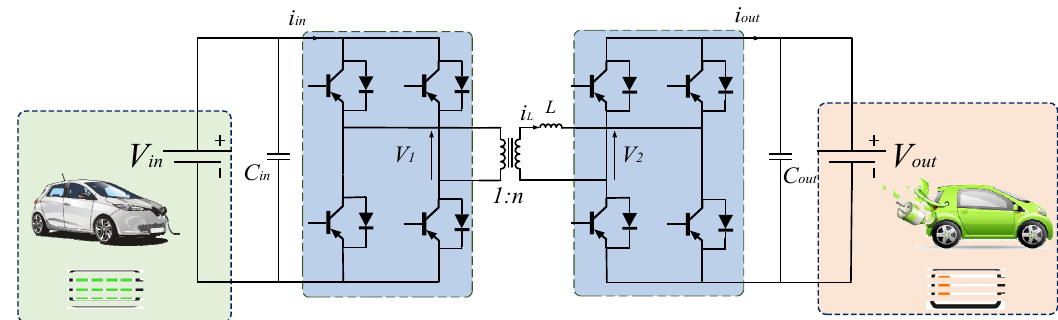
Figure 2. Power structure of the proposed EPBC with the DAB dc-dc converter.